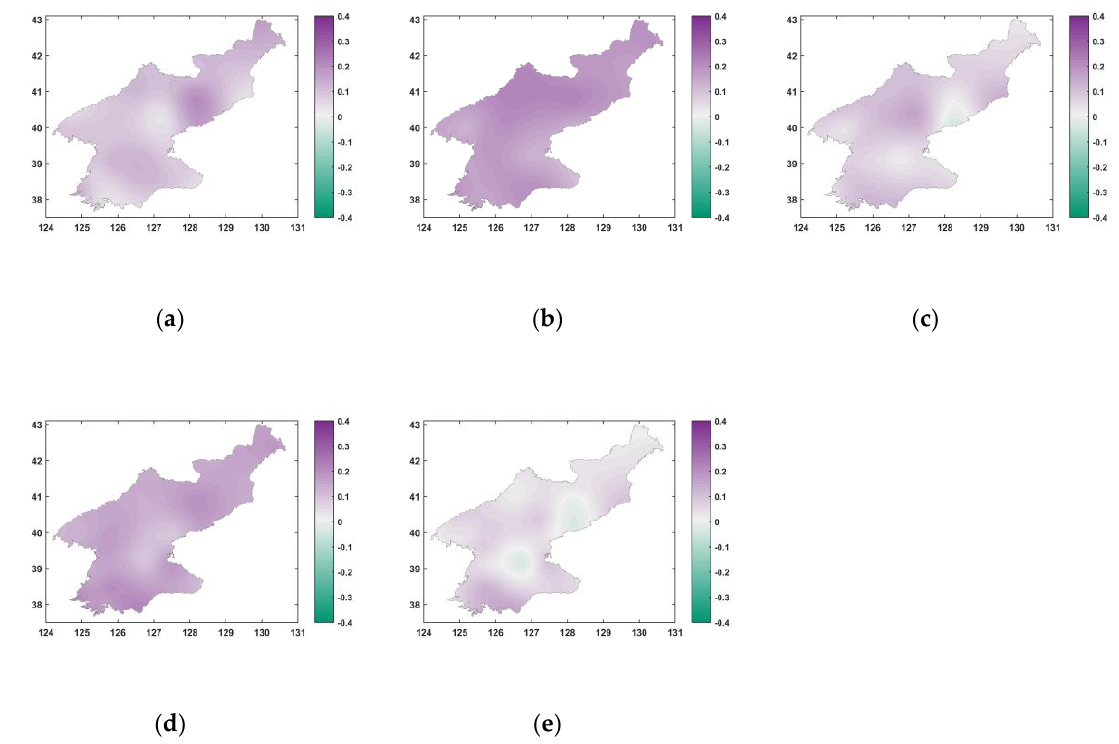
Figure 6. Coefficient of variation of 20-year return value of AMDP for 25 CMIP5 GCMs for Ref, F3, and the difference between F3 and Ref. ( a ) Ref, ( b ) F3 under RCP4.5, ( c ) F3 under RCP4.5 minus Ref, ( d ) F3 under RCP8.5, and ( e ) F3 under RCP8.5 minus Ref.